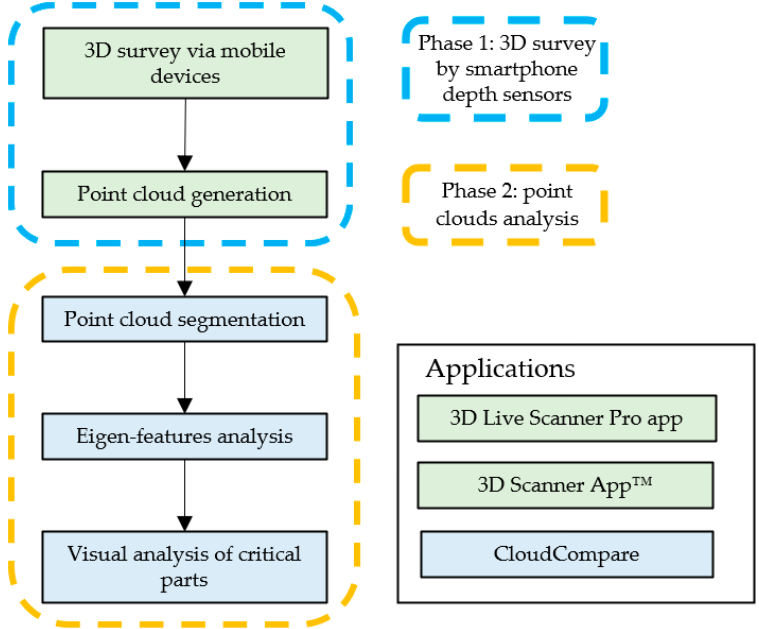
Figure 1. Pipeline of the research methodology.